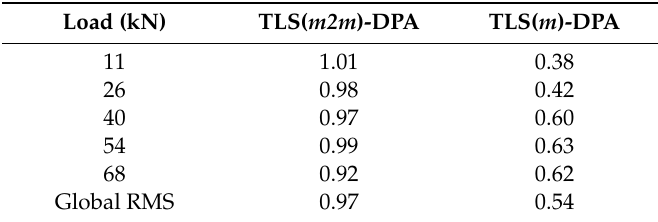
Table 6. RMS (mm) of each TLS methodology with DPA beam#1 LC1.